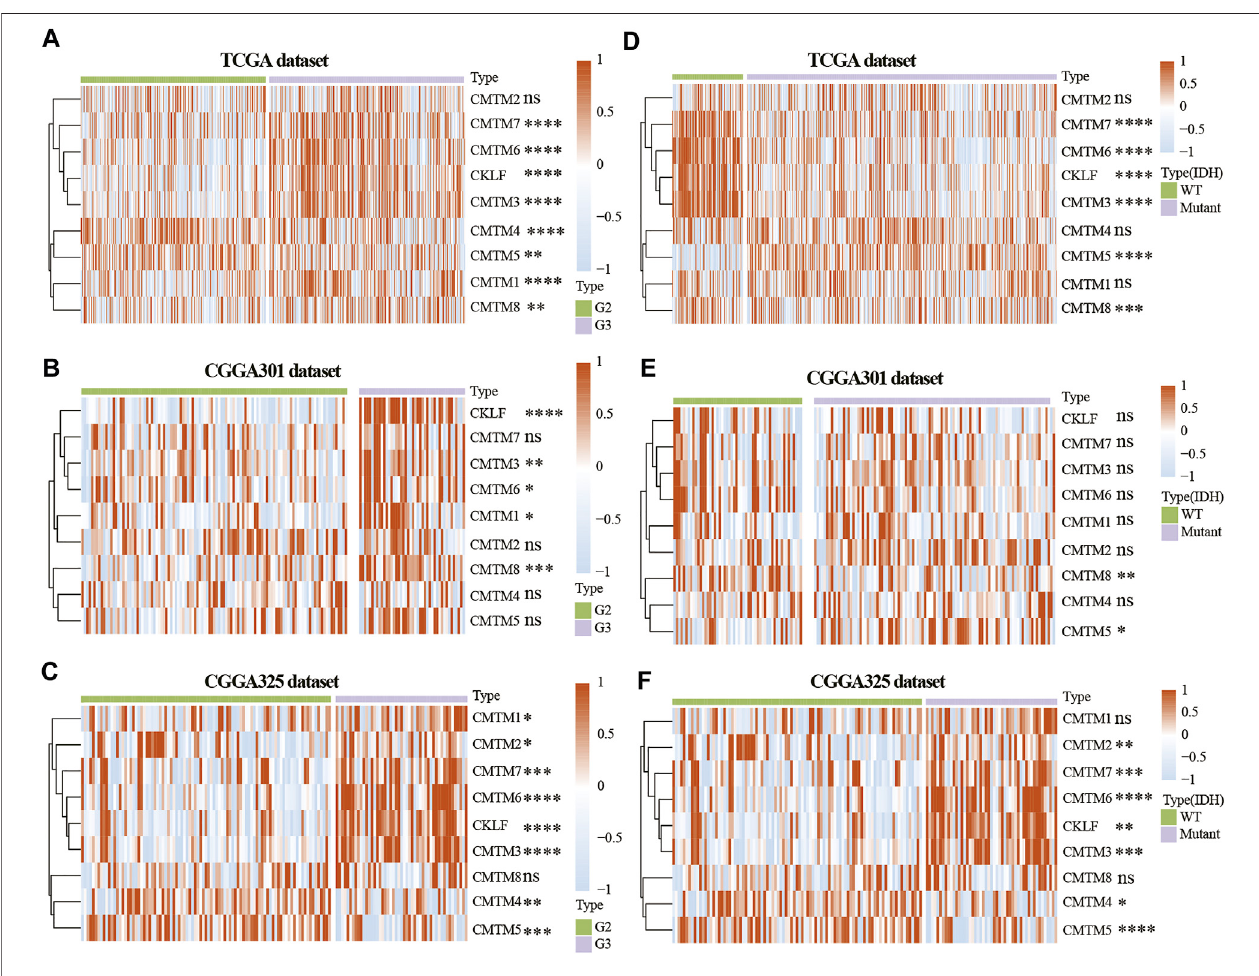
FIGURE 2 | Expression of CMTM family genes in LGG in training and validation cohorts. Expression of CMTM family genes in different grades in the TCGA (A) , CGGA301 (B) , and CGGA325 (C) datasets. Expression of CMTM family genes in different IDH subgroups in the TCGA (D) , CGGA301 (E) , and CGGA325 (F) datasets. The Wilcox test was used to compare the difference between two groups (ns: no signi fi cant difference, * p < 0.05, ** p < 0.01, *** p < 0.001, and **** p < 0.0001).